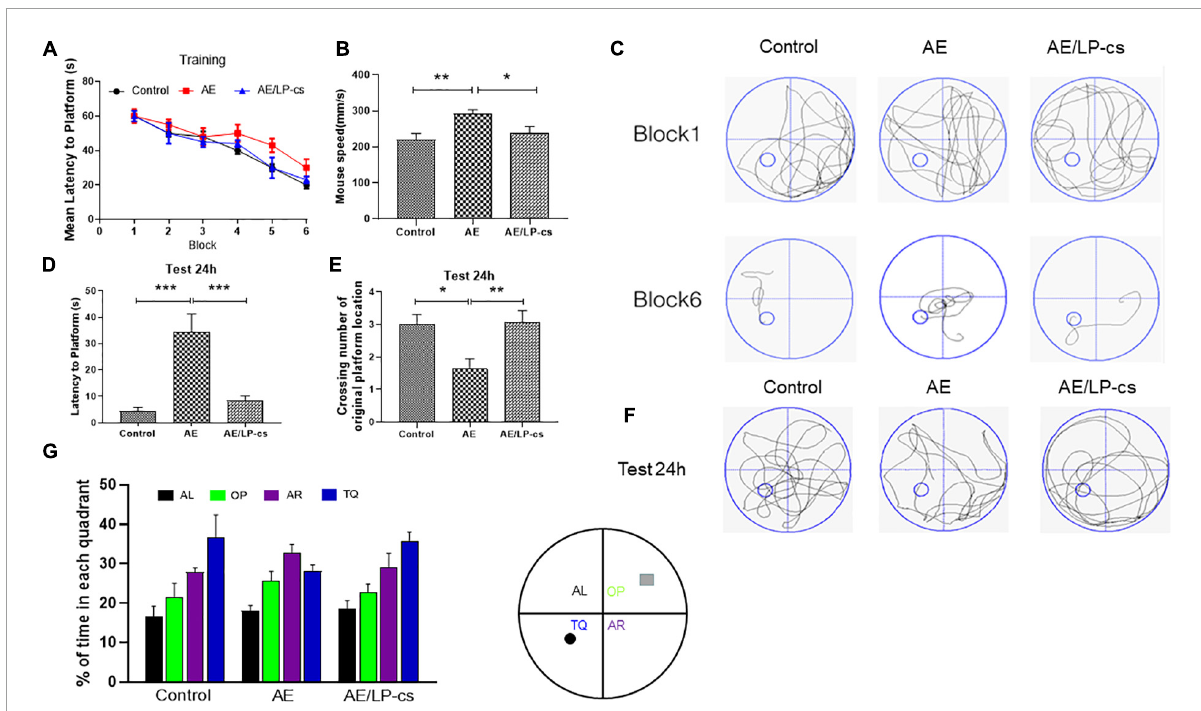
FIGURE1 Lactobacillus plantarum culture supernatants rescues learning and memory impairment by induced alcohol. (A) The learning curve of training period of mice during six blocks in the Morris water maze test. (B) Swimming speed of mice in control, AE, and AE/LP-cs mice during Morris water maze test. (C) Representative swimming track of mice at blocks one and six during the training period. (D) Latency time to find the platform of mice in the probe trial (24 h after training). (E) Number of crossing over the original platform location of mice in the probe trial (24 h after training). (F) Representative swimming track of mice in the probe trial (24 h after training). (G) Percentage of residence time in each quadrant of mice in each group. The quadrant with the platform was designated as TQ, and the quadrant from which the mice started their swimming was designated as OP for “opposite”; the quadrant on the left side of OP was designated as AL for “adjacent left,” and the quadrant on the right side of OP was designated as AR for “adjacent right.” Control vs. AE and AE vs. AE/LP-cs, * p < 0.05, ** p < 0.01, *** p < 0.001, n =